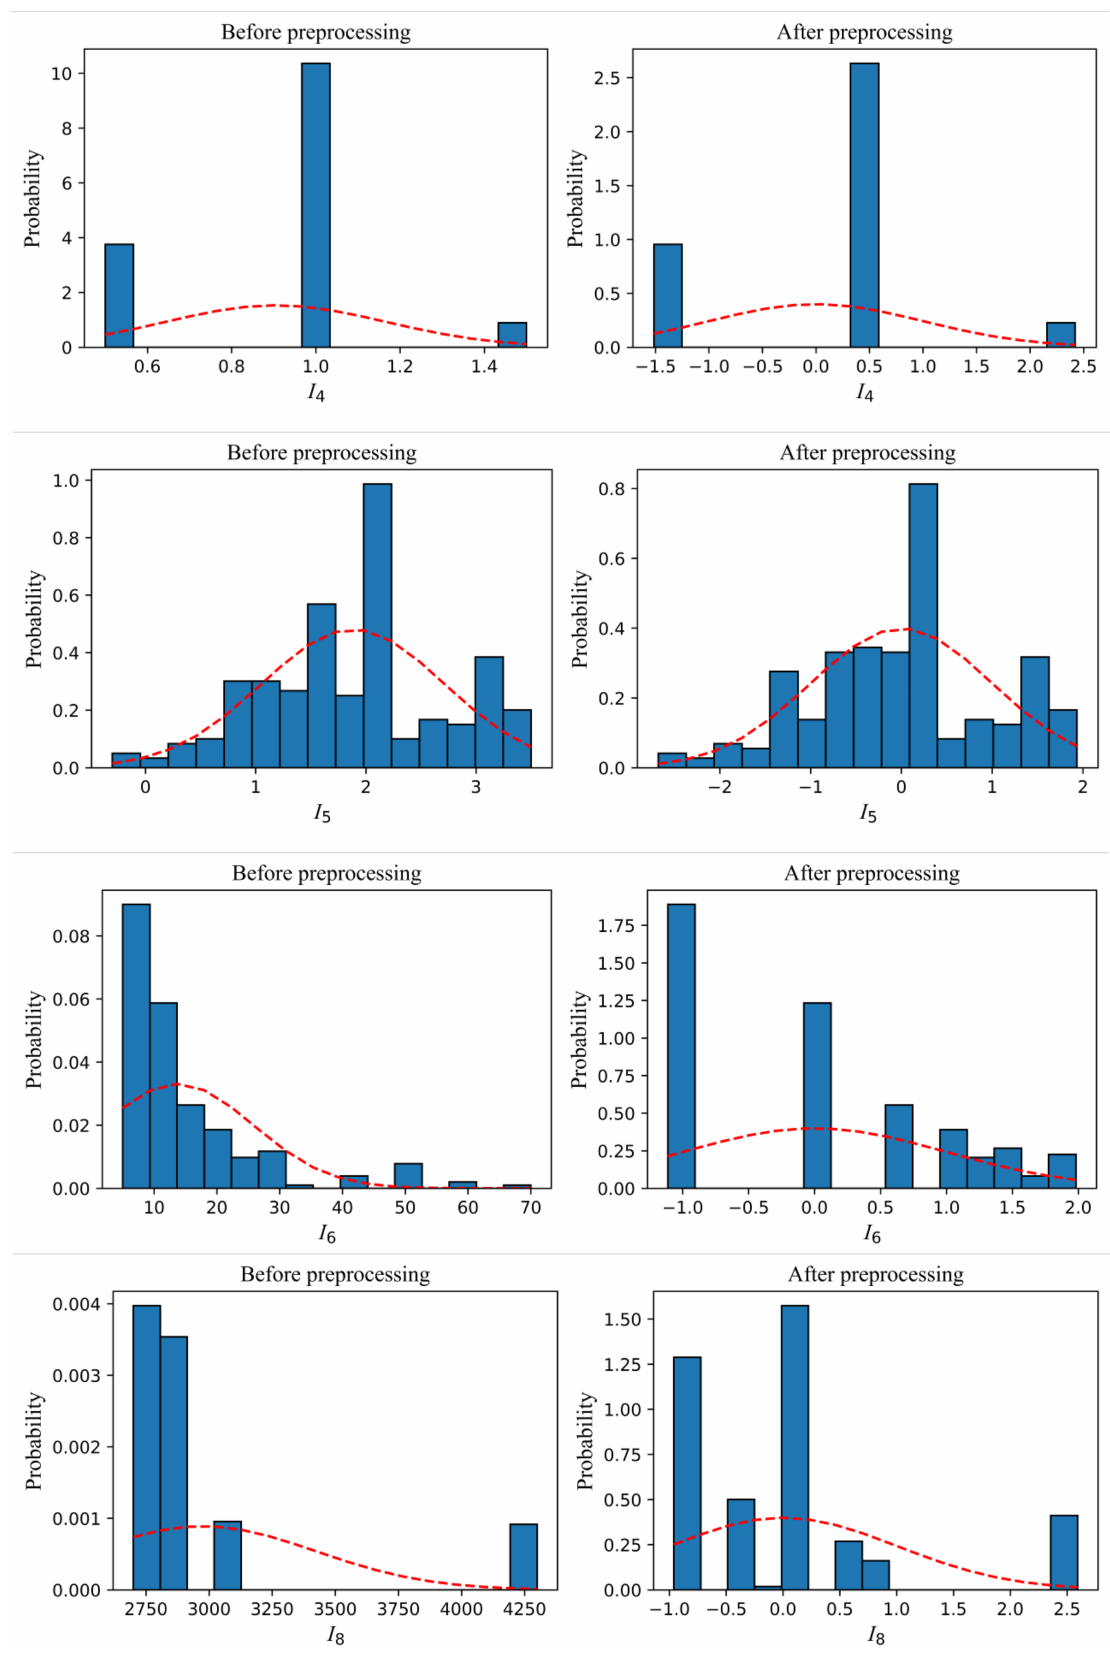
Figure 5. Distribution of indicator values before and after